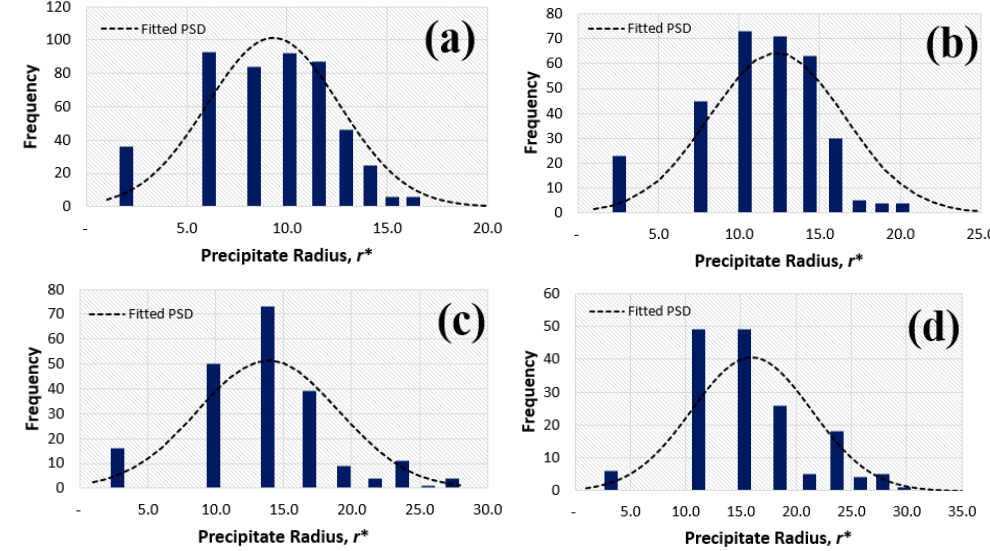
Figure 9. Histograms of the PSD in presence of 30% nanoparticles of size 10 at different times t * of: ( a ) 1000, ( b ) 2500, ( c ) 10,000, and ( d )